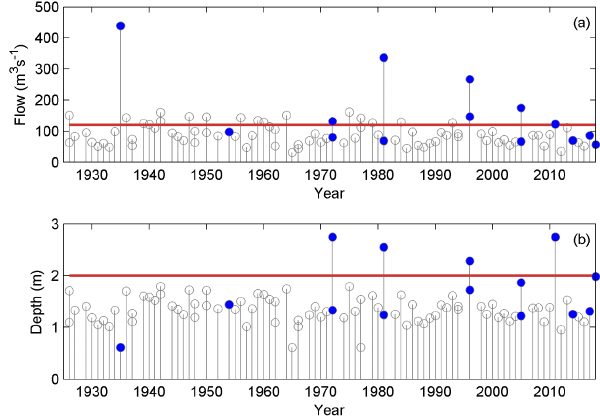
Figure 4. Annual block maxima: (a) peak instantaneous discharge and (b) peak stage for Fall Creek. Blue dots indicate that the event was identified as a flood by at least one survey response. Red lines indicate the hazard thresholds for (a) exceeding channel capacity, and (b) overtopping the 2m levee within the City of